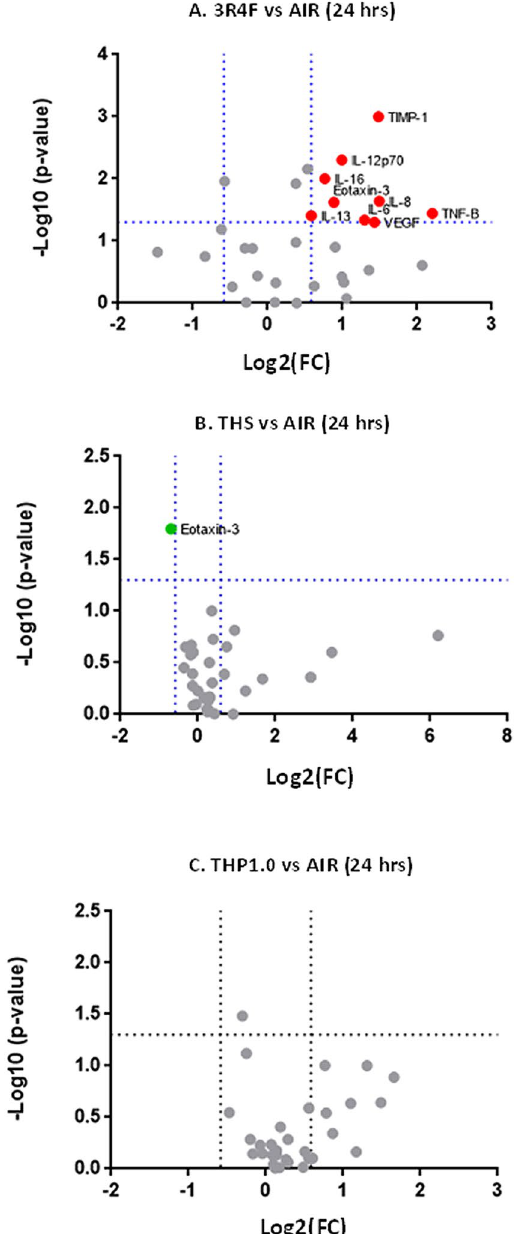
Figure 8. Volcano plots for a panel of 34 cytokines and MMPs quantified in the supernatants from three donors comparing the following treatments: 3R4F vs air ( A ) THS vs air ( B ) and THP1.0 vs air ( C ). The doted blue lines show the − log10(p-value = 0.05) and log2(FC = ± 1.5) thresholds. Markers that were significant at these thresholds are annotated on the plots and colored in red for increase and green for